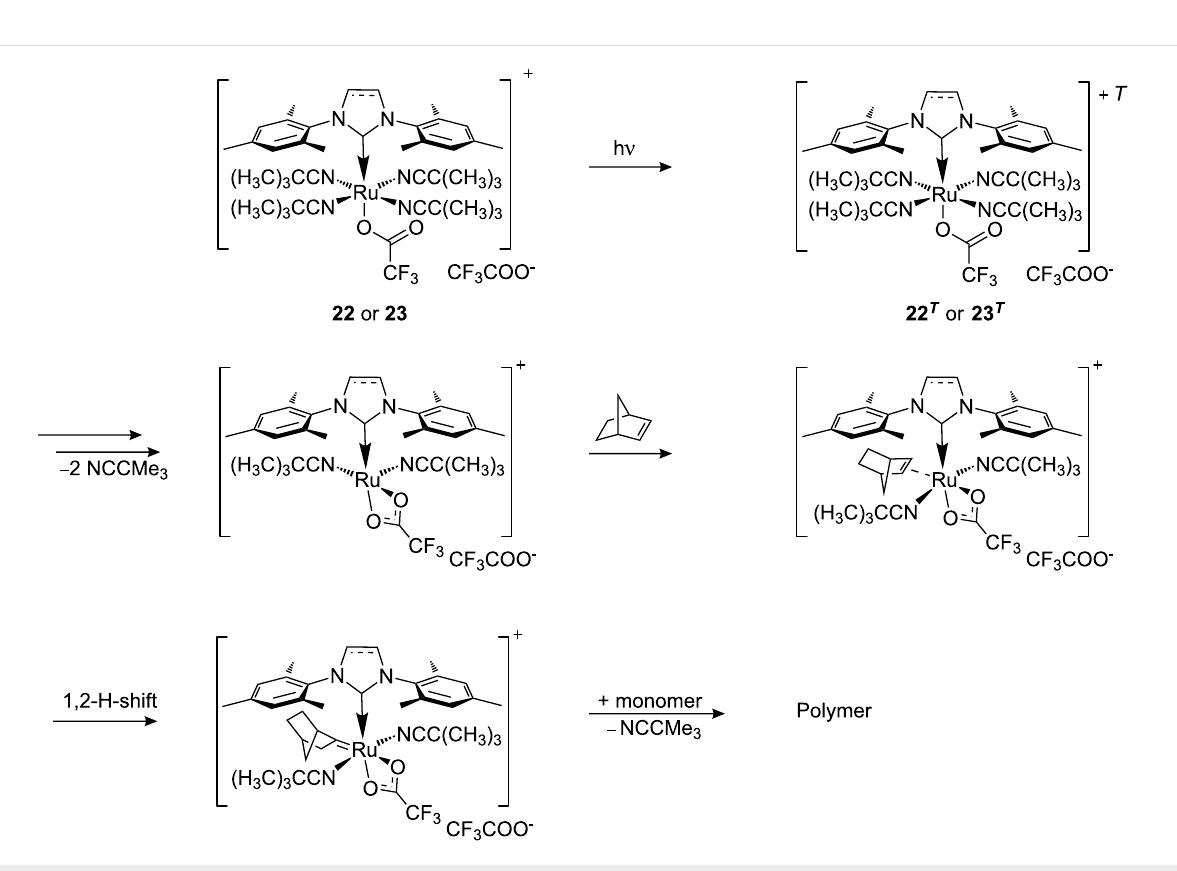
Scheme 6: Proposed mechanism for photoinitiated polymerisation by 22 and 23 .